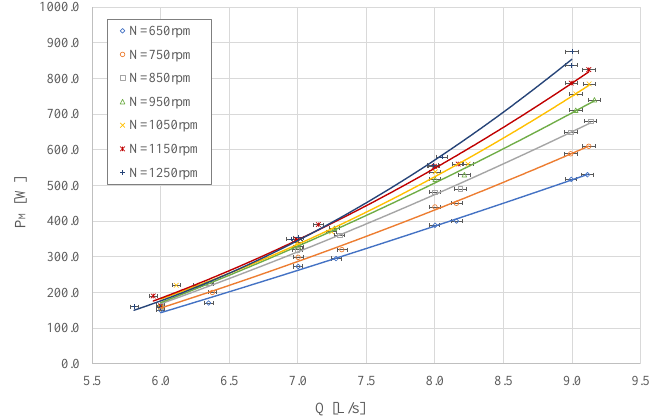
Figure 8. Data from Test Series 1 and 2 and interpolating lines of mechanical power vs. flow rate through the PAT, each referring to a specific rotational speed of the